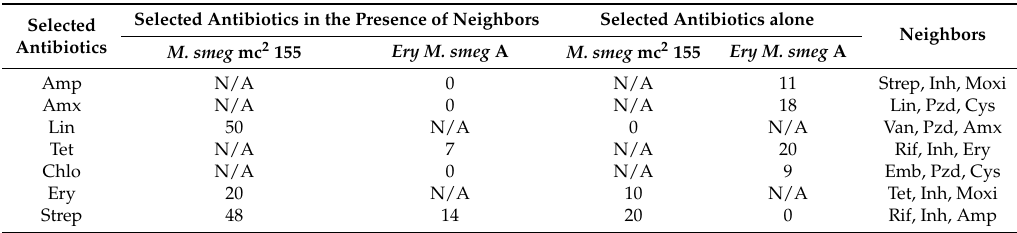
Table 3. Selected Table 3. Selected antibiotics.